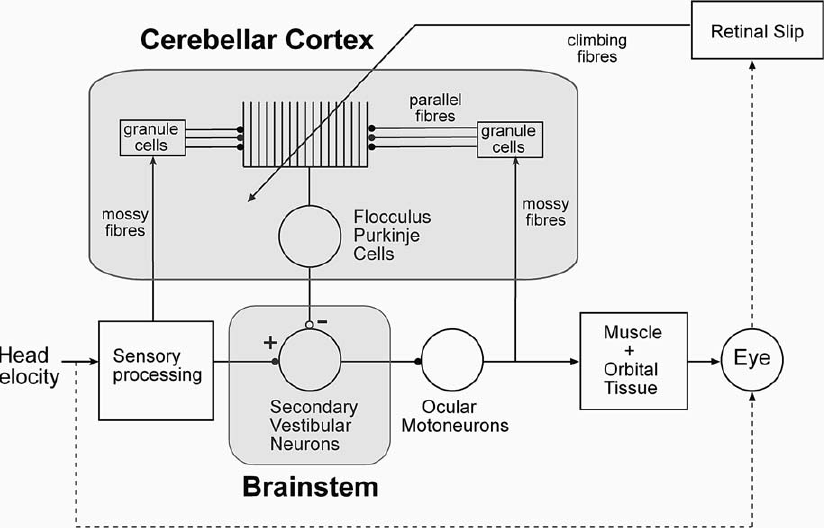
Figure 1. Simplified Diagram of the Circuitry That Mediates the Horizontal VOR Head-velocity signals are processed by the semicircular canals and primary vestibular neurons, relayed to secondary vestibular neurons in the brainstem, and then passed to ocular motoneurons (the classic 3-neuron arc). Motor command signals from the motoneurons control the oculomotor plant, i.e., eye muscles plus orbital tissue, in order to produce eye movements that counteract the effects of the head velocity on the retinal image. Inaccurate eye movements produce retinal slip, which is detected by the visual system. A side loop to the main 3-neuron arc passes through the floccular region of the cerebellum. This region of cerebellar cortex receives as mossy fiber input vestibular information and a copy of the motor command sent to the eye muscles. These mossy fiber inputs are converted into parallel fiber signals by granule cells and associated circuitry in the granular layer, and the parallel fiber signals influence simple spike firing ( ; 100 spikes/s) in Purkinje cells. Variation in simple spike firing is transmitted to a subset of secondary vestibular neurons (floccular target neurons) in the brainstem. The flocculus also receives a retinal-slip signal as climbing fiber input, which produces low-frequency ( ; 1 spike/s) complex spikes. Evidence from studies of VOR adaptation suggest that there are two sites of neural plasticity, one in cerebellar cortex and one in brainstem [8,44]. The simplified diagram omits cerebellar interneurons, and shows the efference copy of the motor commands as originating from the oculomotor neurons themselves. In reality this signal appears to originate from a number of areas, in particular the cell groups of the paramedian tracts